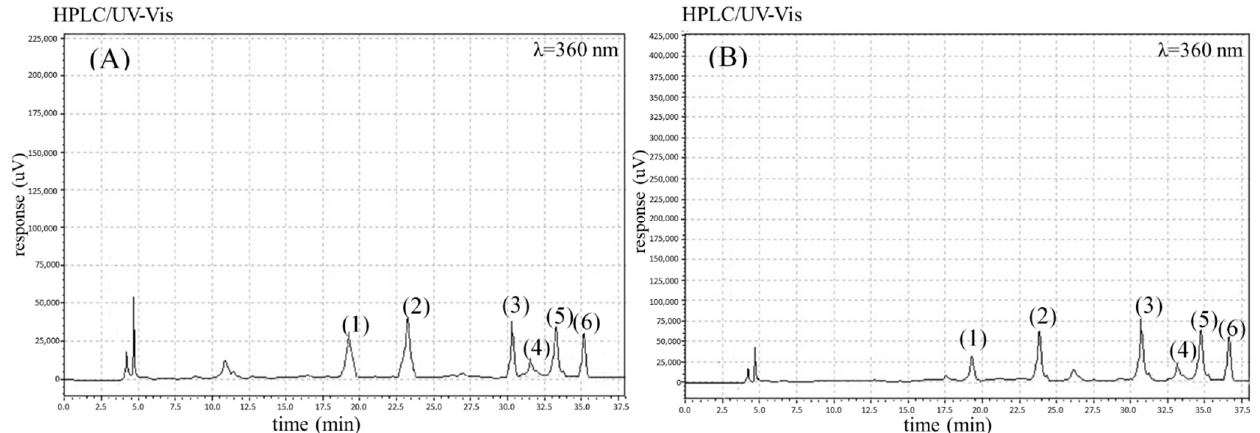
Figure 2. The chromatograms showing the retention time for flavonoids in the selected organic ( A ) and conventional ( B ) carrot samples: (1) quercetin-3- O -rutinoside, (2) kaempferol-3- O -glucoside, (3) luteolin, (4) apigenin, (5) quercetin-3- O -glucoside, and (6) kaempferol.